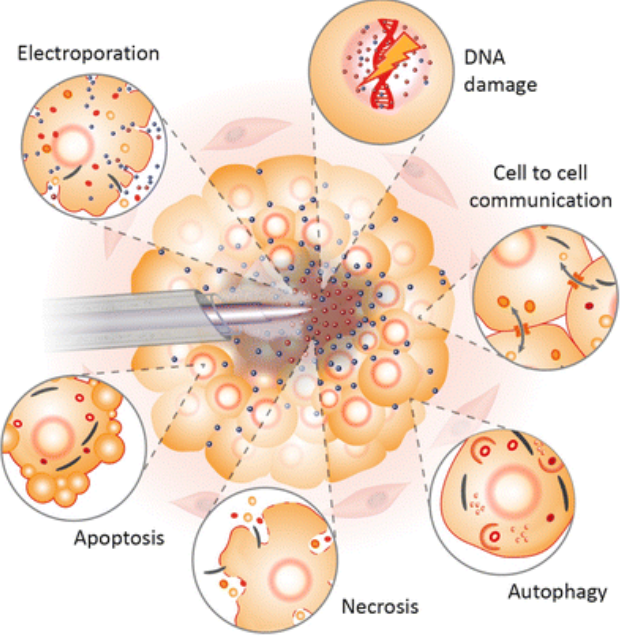
Figure 9. LTP tumour treatment by inserting the probe into the tumour core